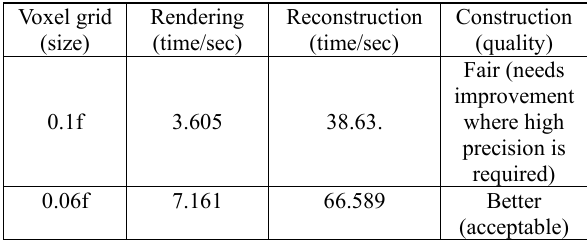
Figure 18 . 3D reconstruction effect (Left is0.1f, Right is 0.06f) Table 3 . Comparison of data from different point cloud